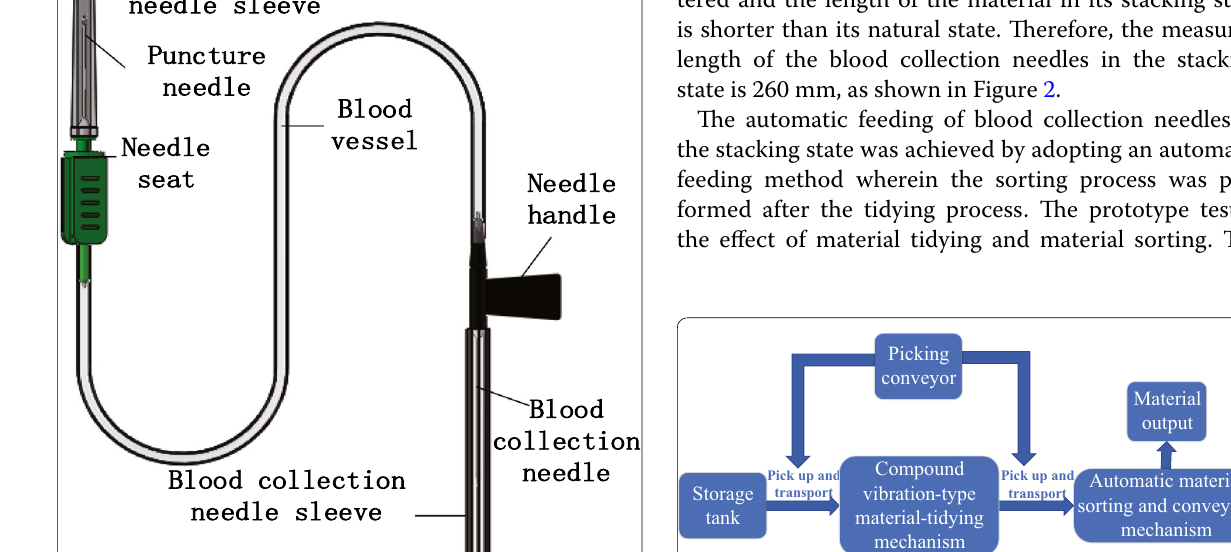
Figure 1 Structure of blood collection needle